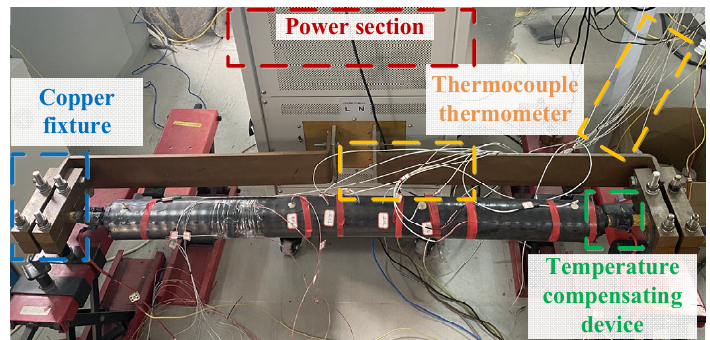
Figure 3. Diagram showing the high-voltage cable thermal parameter detection control platform.